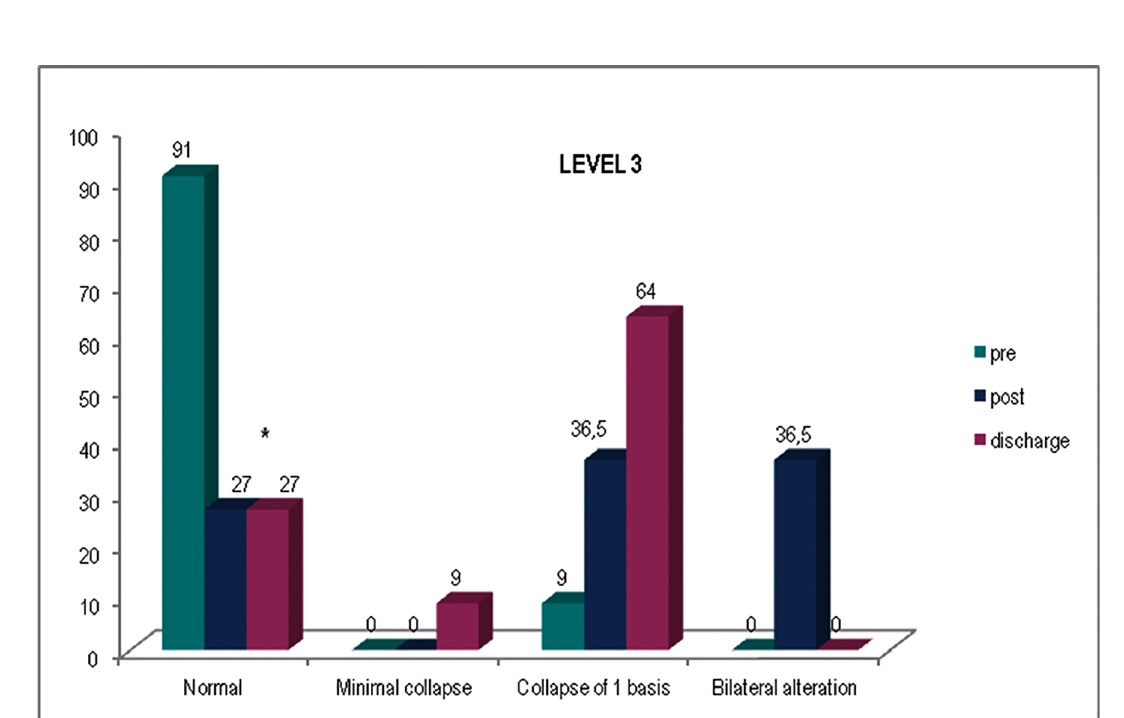
Fig. 4 - Percentage of radiological changes of level 3 in the pre, post and discharge of